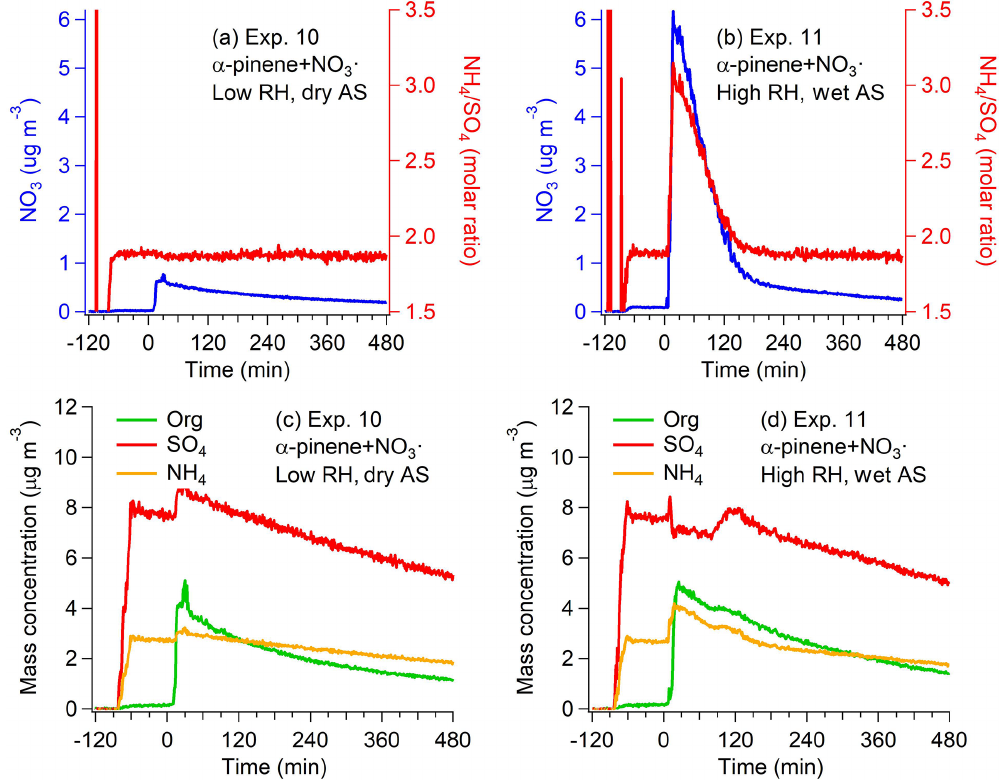
Figure 2. (a, b) NO 3 concentration and the molar ratio of NH 4 to SO 4 and (c, d) concentrations of Org, SO 4 , and NH 4 measured by HR- ToF-AMS. Data presented in panels (a) and (c) are from Exp. 10 (low RH, dry AS), while those in panels (b) and (d) are from Exp. 11 (high RH, wet AS). These two experiments are essentially the same except for RH and phase state of seed